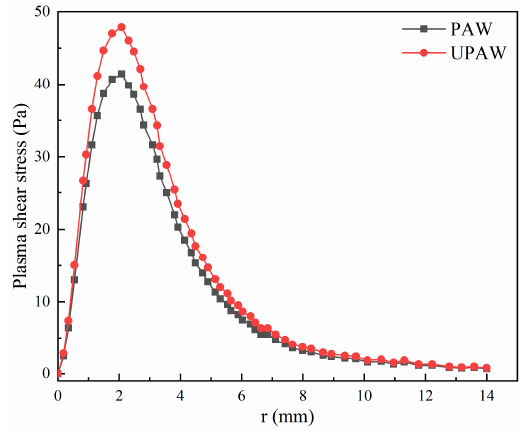
Figure 3. Gas shear stress distribution (welding current 80 A).